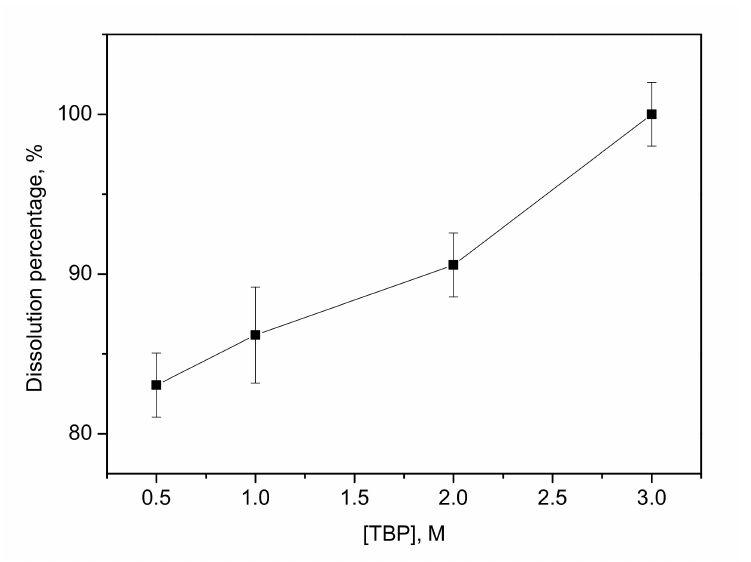
Figure 2. Effect of tributyl phosphate (TBP) concentration on the dissolution of Pd. Conditions: [TBP] = 0.5 M to concentrated; diluent: kerosene; Pd/H 2 O 2 ratio = Pd/HCl ratio = 10g/L; 60 ◦ C, 60 min.